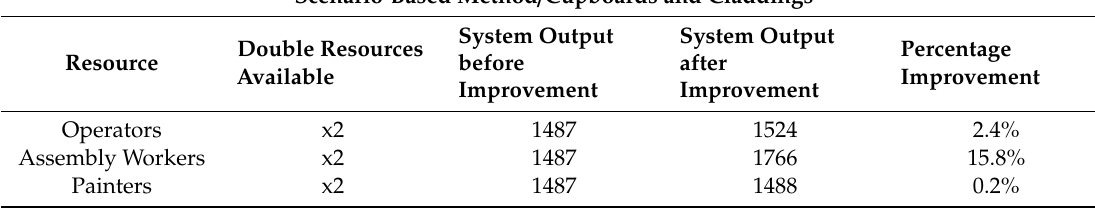
Table 9. Scenario-based